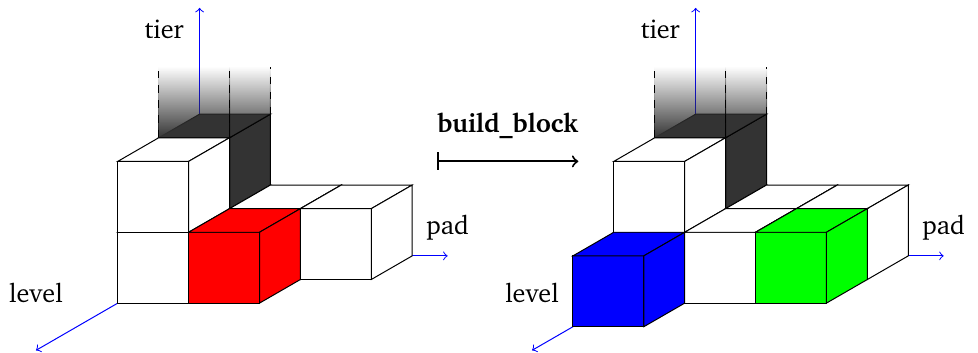
Figure 17: Visualization of the three-dimensional Young diagram partitioning of free- fermionic Hilbert space, at some point during the search. The red block is the current block the algorithm uses to produce states. When build_block is called, if still unex- plored, it explores the column of the green block, and if self.peps ≤ 1, also the blue, constructing their excitation profiles and the local tiers they use. Then it adds the green (blue) block(s) to self.cart